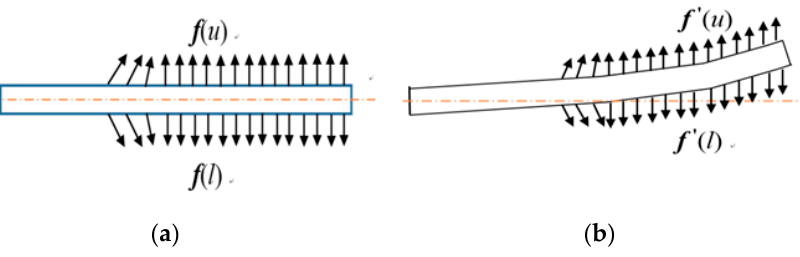
Figure 4. The electric filed forces on the vibrating plate: ( a ) The electric forces on the plate at rest ( b ) The electric forces on the deflected plate.